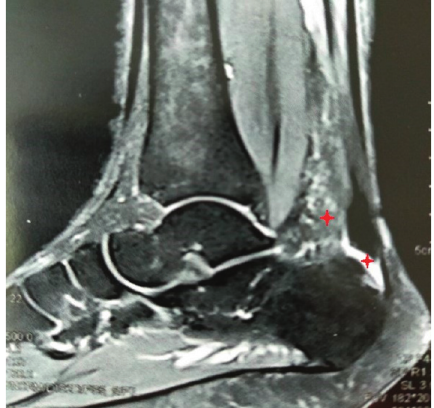
Figure 2: Magnetic resonance imaging T 2 sequence, sagittal view showing an increased signal intensity of the retrocalcaneal bursa with marked fibrosis anterior to the Achilles tendon (red